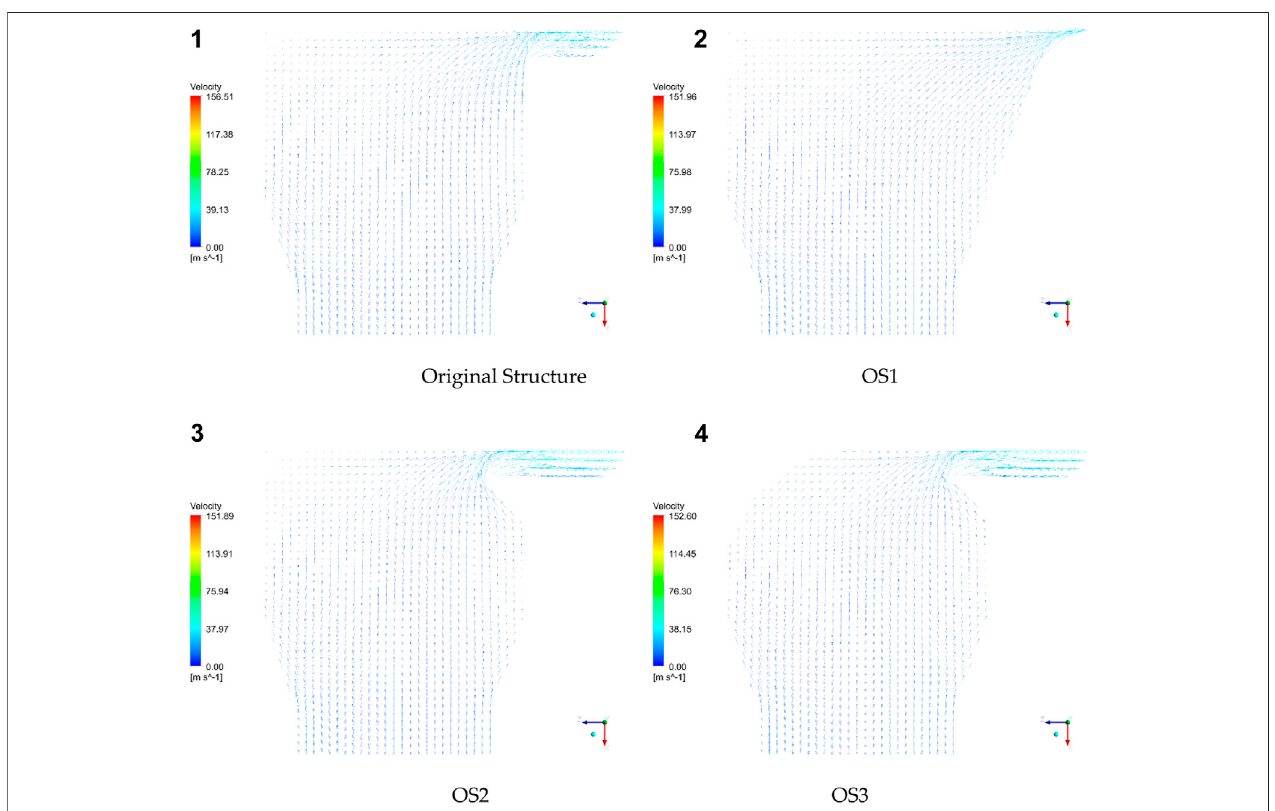
FIGURE 15 | Velocity vector fi elds of different OS